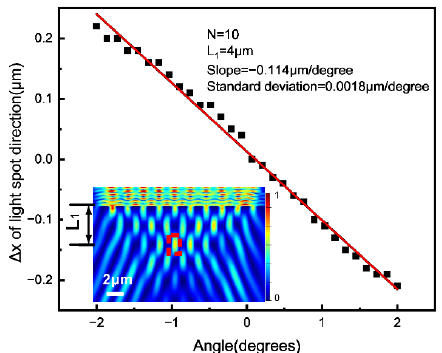
Figure 2. Simulated normalized intensity field of Talbot images behind G1. Simulations of Talbot images with θ of 0°, 1° and 2°, respectively.